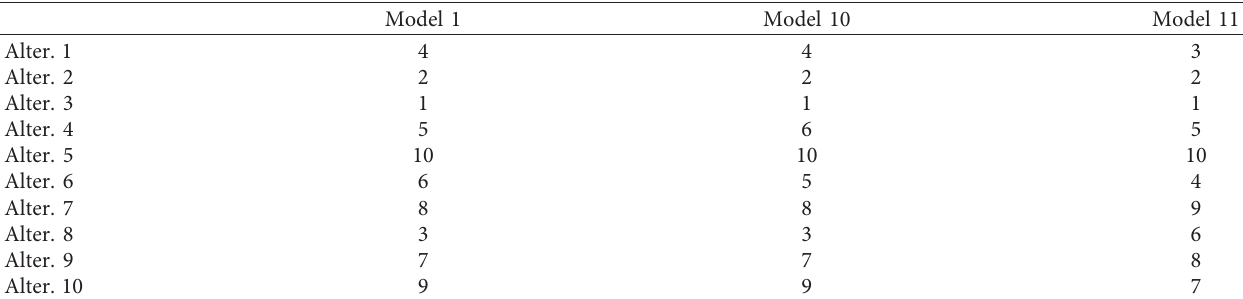
Table 19: Comparison of the ranks of alternatives according to models 1, 10, and 11.